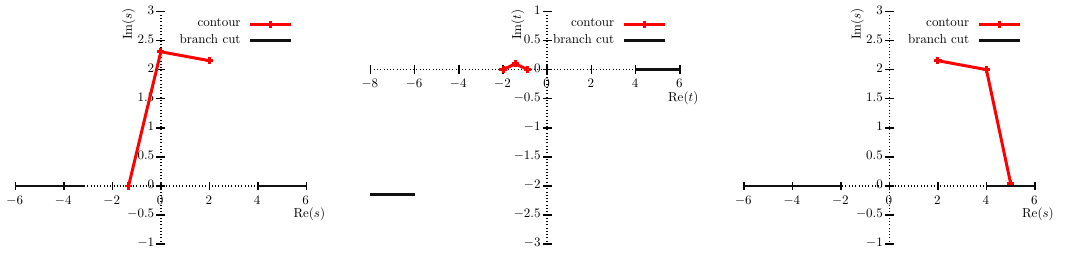
Figure 2. The integration contour (red) and relevant branch cuts (black) are shown for F 3 , starting from IC1. Note that the branch cut corresponding to u = 4 to u = F 2 one has an additional branch cut from s = 0 to s =